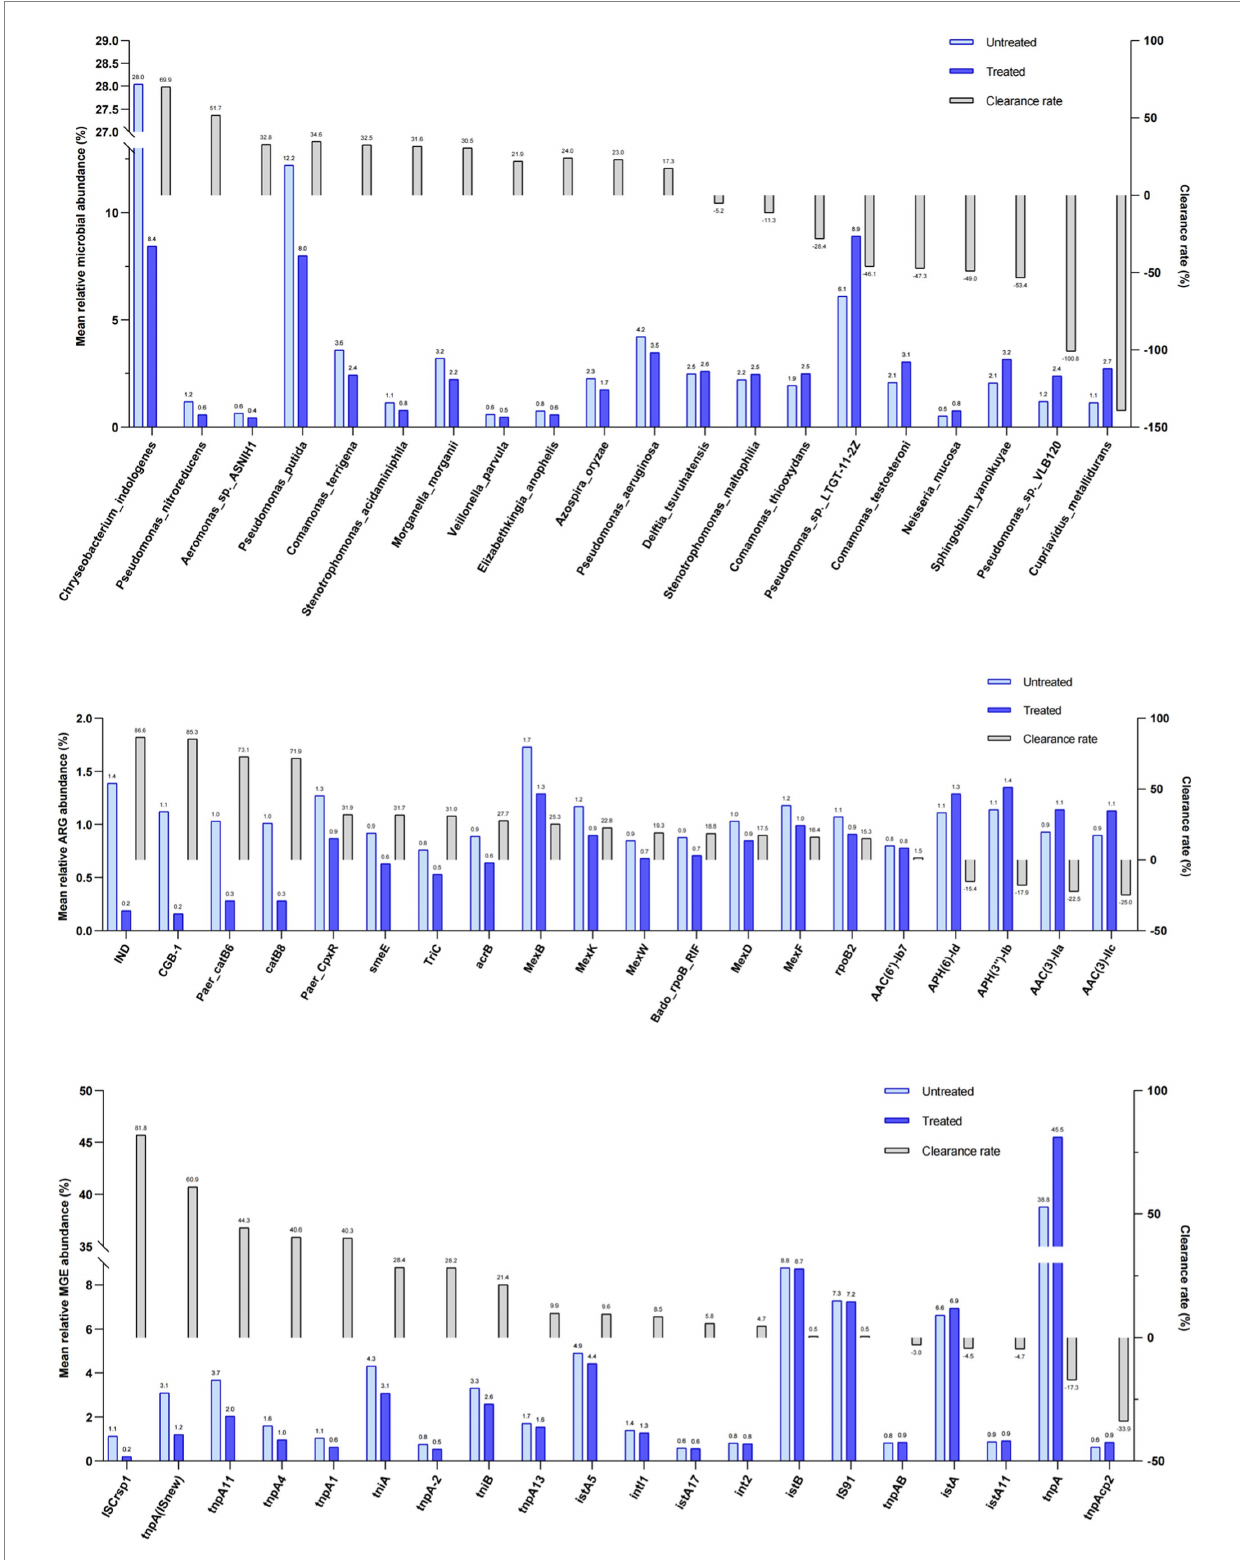
FIGURE 3 Changes in relative abundance of bacteria, ARGs and MGEs in the untreated and treated dental waste waters and their clearance rate. Light blue and dark blue columns show the mean relative abundance of bacteria (A) , ARGs (B) , and MGEs (C) in the two groups. The gray columns show the corresponding clearance